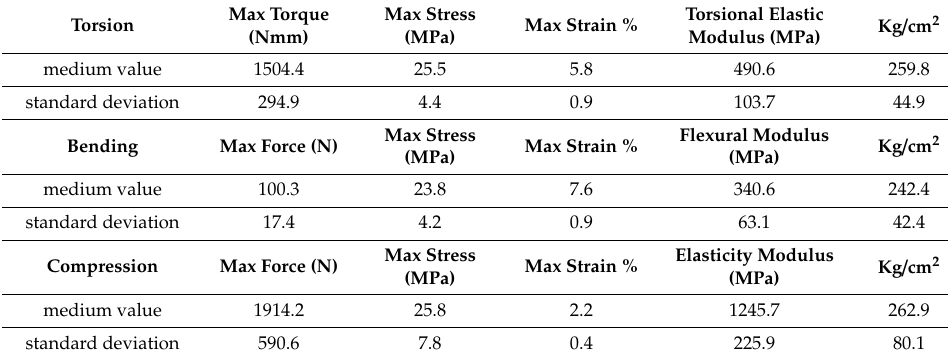
Table 1. SmartBone ® mechanical properties (adapted from